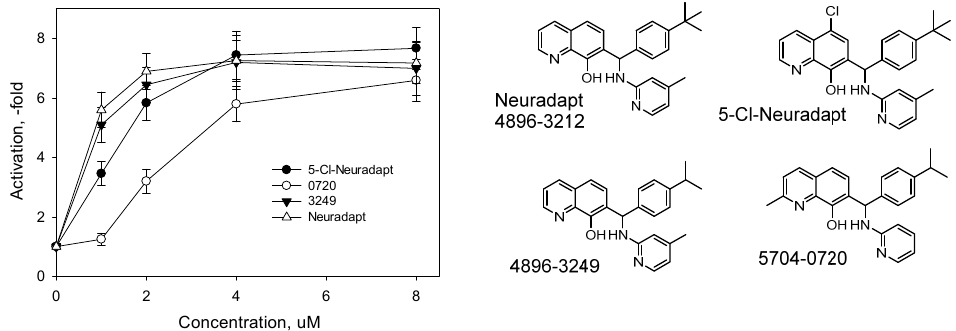
Figure 5. Effect of substitutions in the second and fifth position of the oxyquinoline core on HIF1 ODD-luc reporter activation. 5-Cl-Neuradapt was custom synthesized (See Figure S1). Other compounds are commercially available from ChemDiv (Skolkovo, Russia).